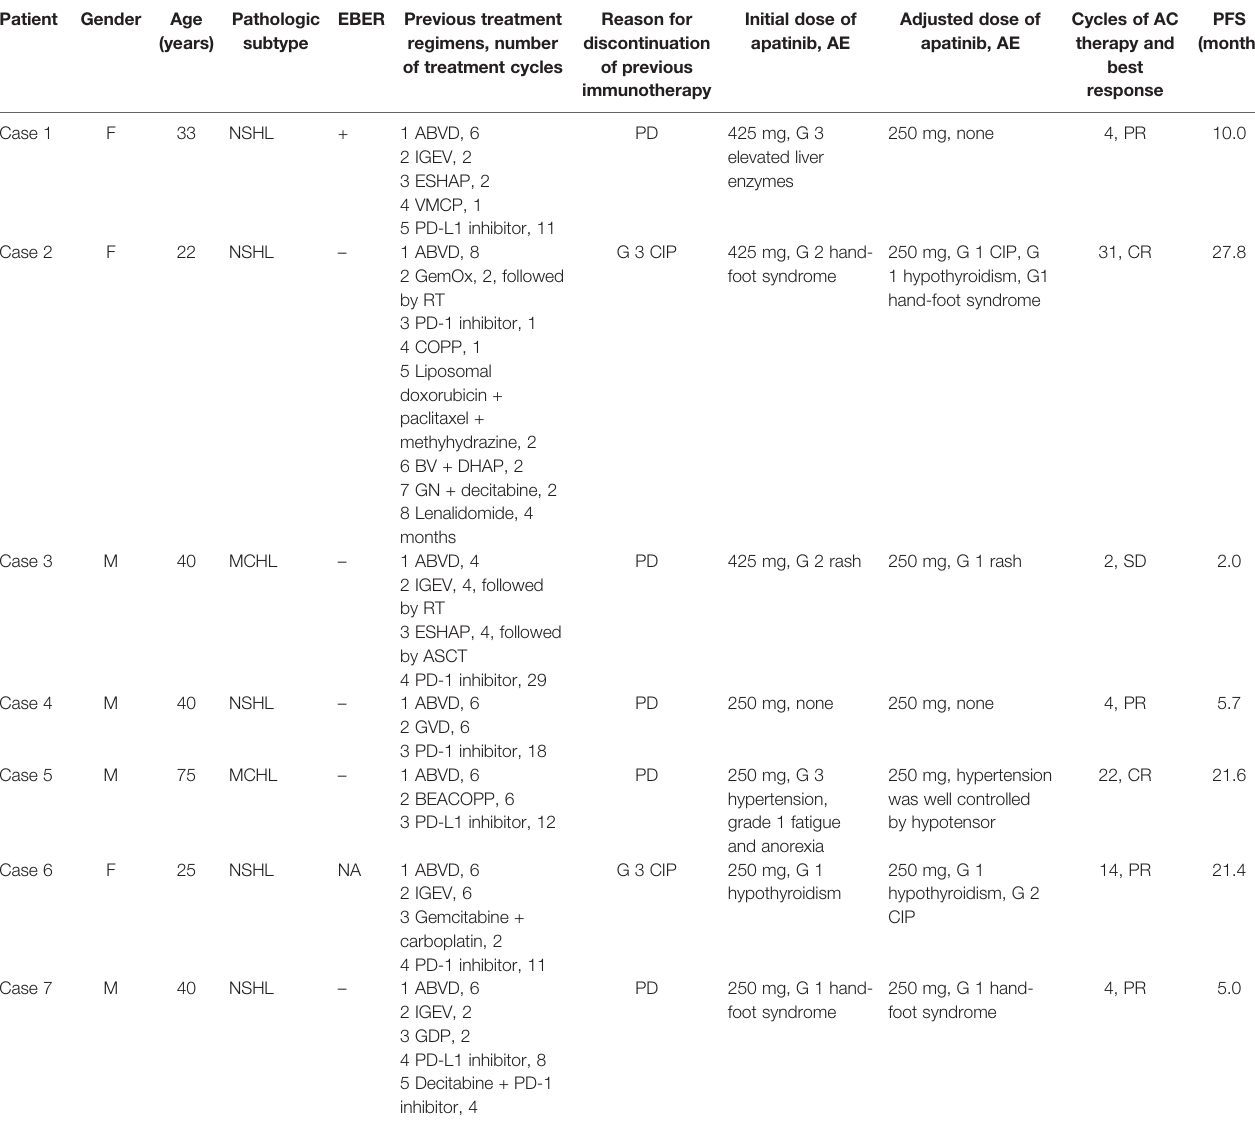
TABLE 1 | Pro fi le of seven patients treated with apatinib plus camrelizumab (AC). Patient Gender Age Pathologic (years)